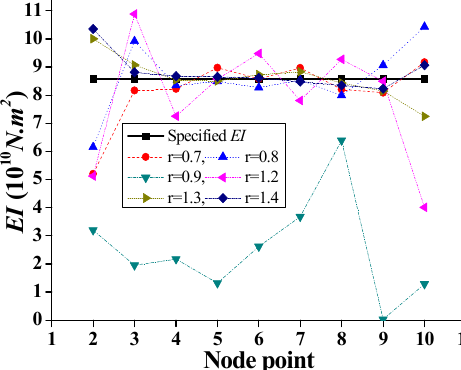
Figure 6. Vertical displacement response of ( a ) bridge midpoint and ( b ) test vehicle.